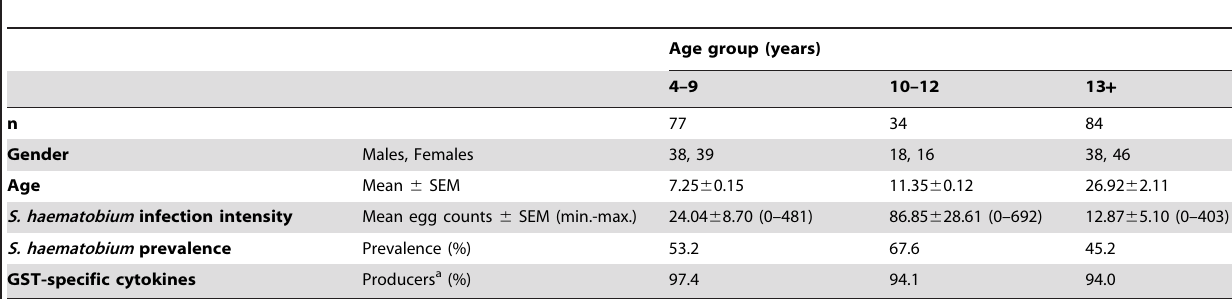
Table 1. Demographic and S. haematobium infection characteristics of the study cohort by age